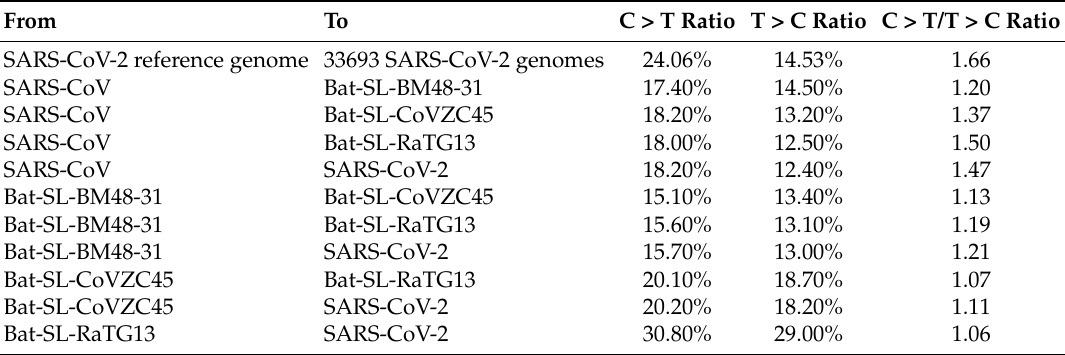
Table 4. The C > T over T > C ratios among SARS-CoV (2003), Bat-SL-BM48-31 (2008), Bat-SL-CoVZC45 (2017), Bat-SL-RaTG13 (2013), and SARS-CoV-2 (2019). From To C > T Ratio T > C Ratio C > T/T > C Ratio SARS-CoV-2 reference genome 33693 SARS-CoV-2 genomes 24.06% 14.53% 1.66 SARS-CoV Bat-SL-BM48-31 17.40% 14.50% SARS-CoV Bat-SL-CoVZC45 SARS-CoV Bat-SL-RaTG13